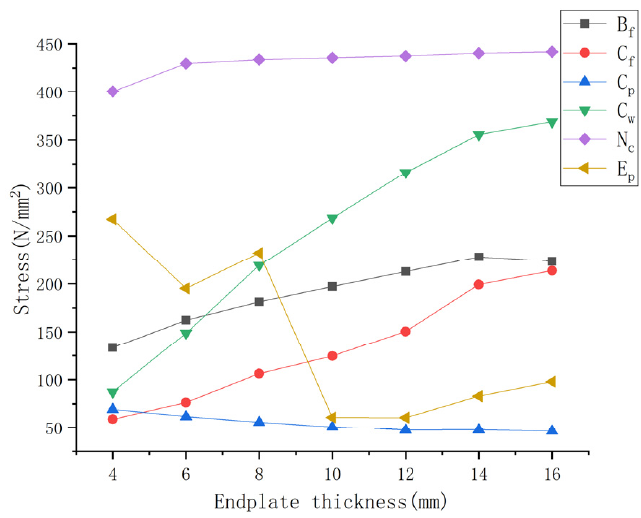
Figure 21. Comparison of stress history at specified points.